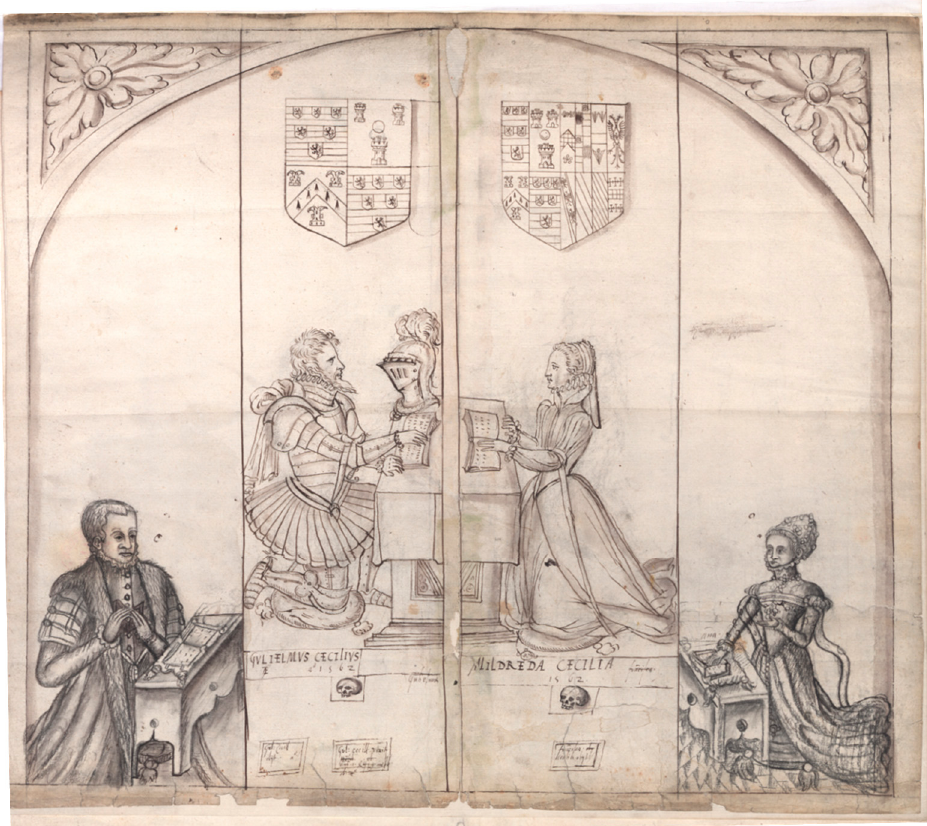
Figure 10. Scheme for a funeral monument, 1562, Cecil Papers, CPM II/14, Hatfield House, Hertfordshire, UK. Courtesy of the Marquess of Salisbury.